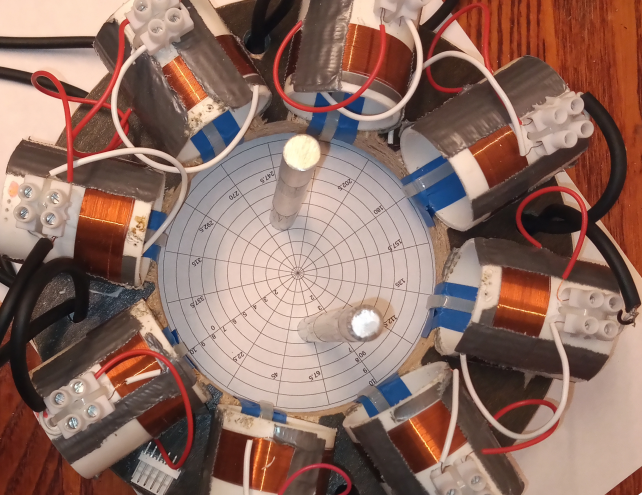
Figure 7. Photograph of inclusion measurements using aluminium rod samples 10 mm in diameter and 100 mm in length, with a 105 mm diameter circular sample space.